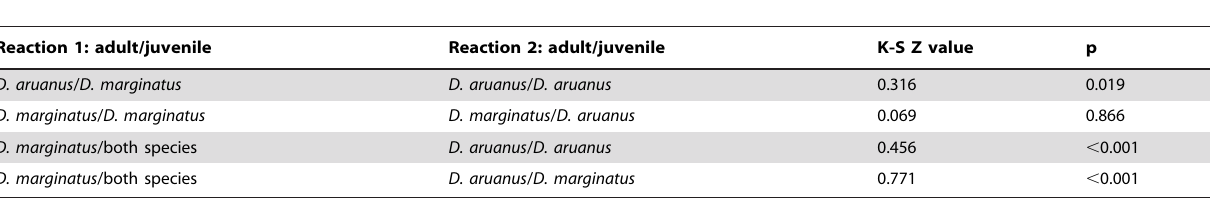
Table 5. Results of two-sample Kolmogorov-Smirnov test comparing the reaction adults towards juveniles.